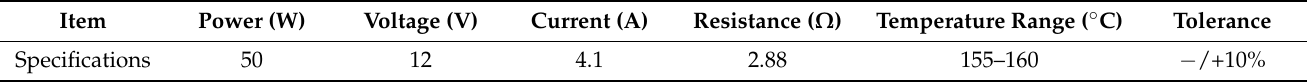
Table 1. Technical details of silicone pad heater.